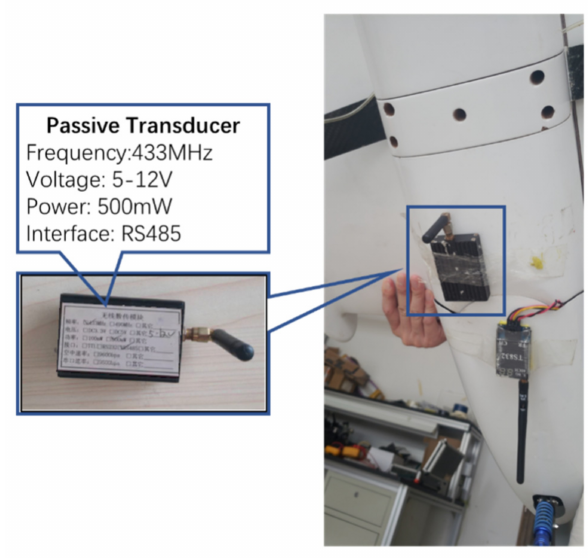
Figure 12. The 433 mHz